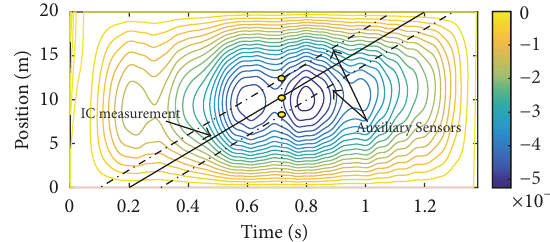
Figure 6: Instantaneous Curvature calculation using three deflec- tion measurements on the healthy